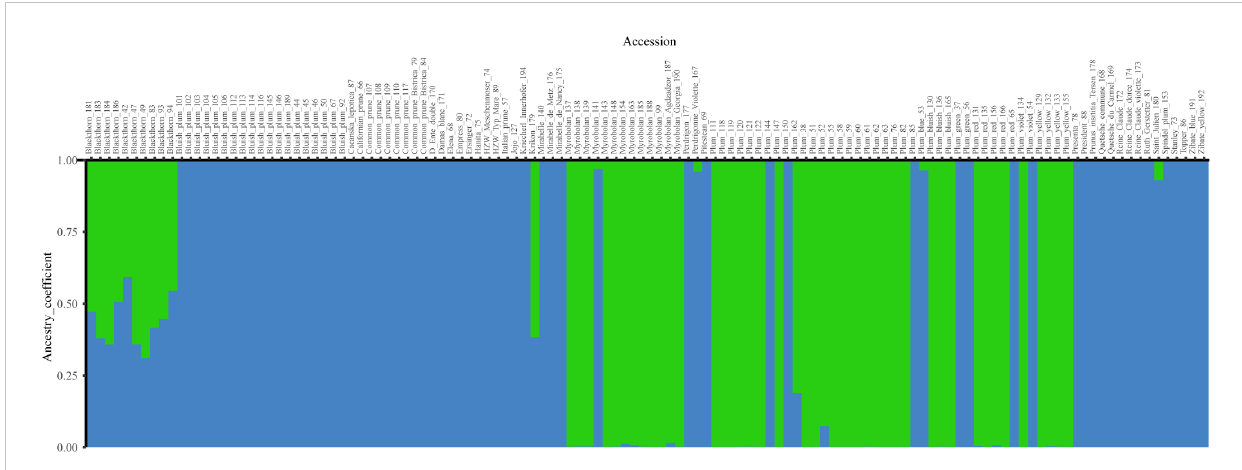
FIGURE 2 Bar plot of Bayesian analysis results (K = 2) for plum species genotypes. P. cerasifera accessions are shown in green (Cluster 1), and P. domestica accessions are arranged in blue (Cluster 2). P. spinosa accessions were